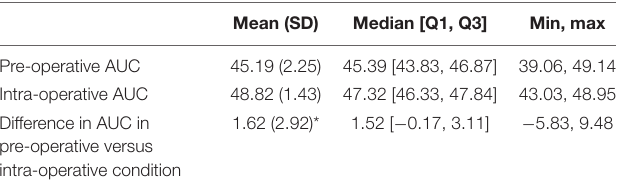
TABLE 2 | Summary of EEG multi-scale entropy area under the curve (AUC) in pre-operative (awake, eyes closed) and intra-operative conditions ( n = 50).